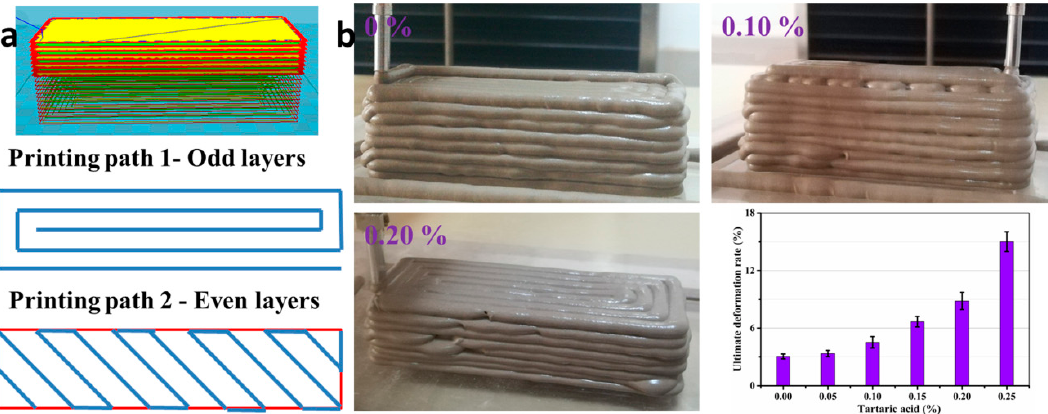
Figure 11. ( a ) The designed model and printing path and ( b ) the macrograph and ultimate deformation rate of the fresh SAC paste for different additions of TA.